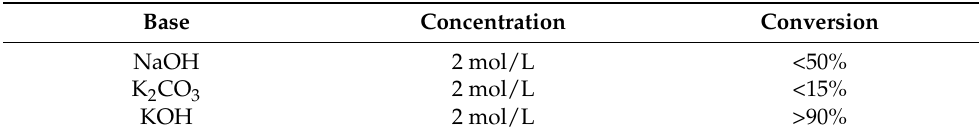
Table 4. Nature of the bases for oxyacetic acid of anacardic acid ( 5 ) synthesis. Base Concentration